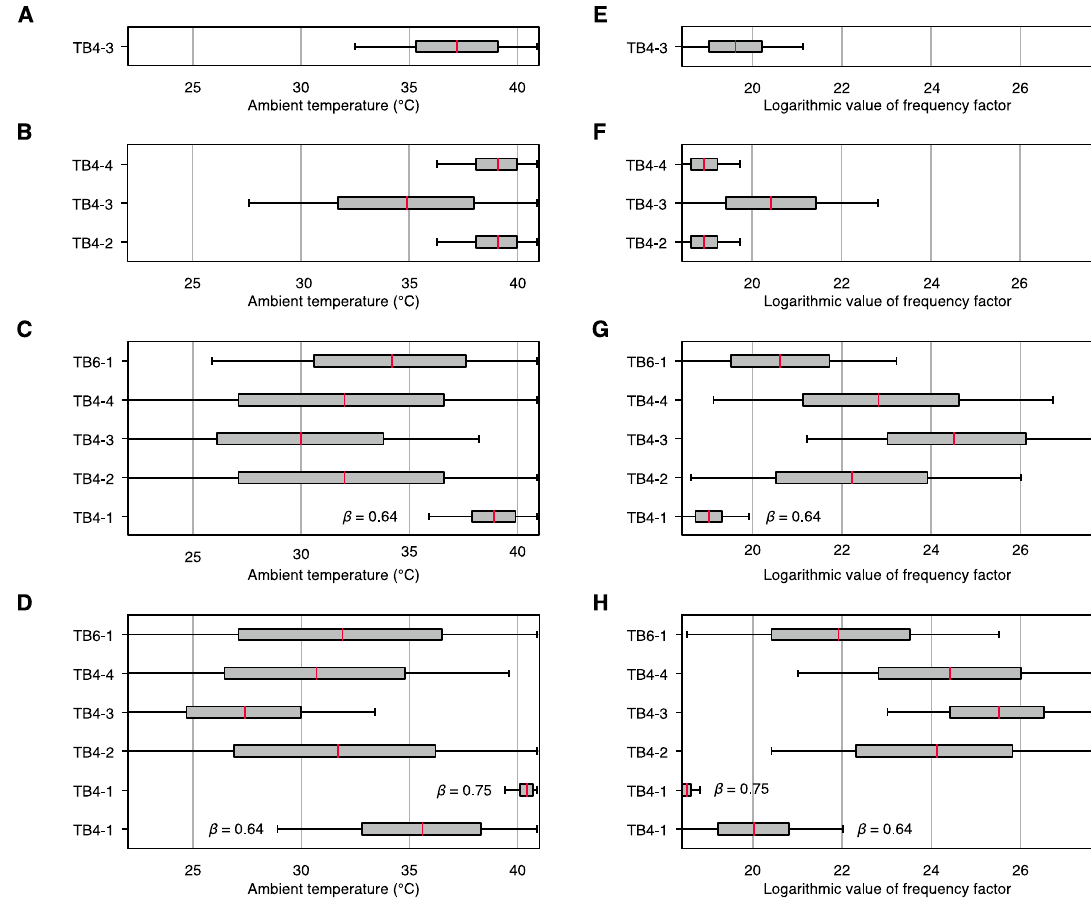
Figure 4. Boxplots of ambient temperature T A and frequency factor C variations for Meiwa tsunami boulders (TB4 and 6). ( A – D ) T A variation and ( E – H ) C variation when the VRM ages correspond to the Meiwa tsunami age. The red lines are the median values for each dataset. ( A ) and ( E ) are for magnetite T C and ( B ) and ( F ) are for maghemite T C based on the Pullaiah nomogram calculation. ( C ) and ( G ) are for magnetite T C and ( D ) and ( H ) are for maghemite T C based on the modified nomogram calculation.